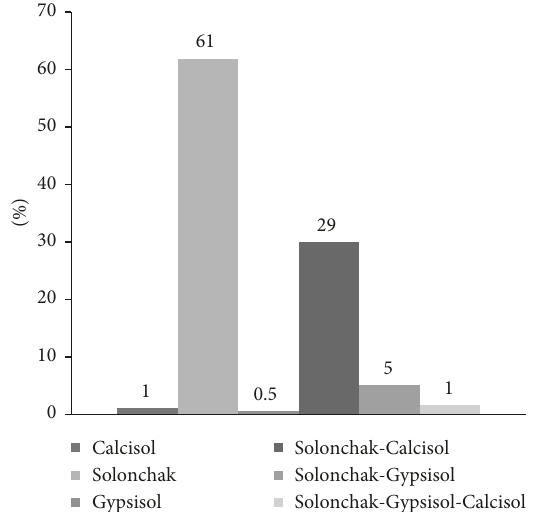
Figure 10: Histogram of soil group frequencies and their Data analyses showed that the relationships between